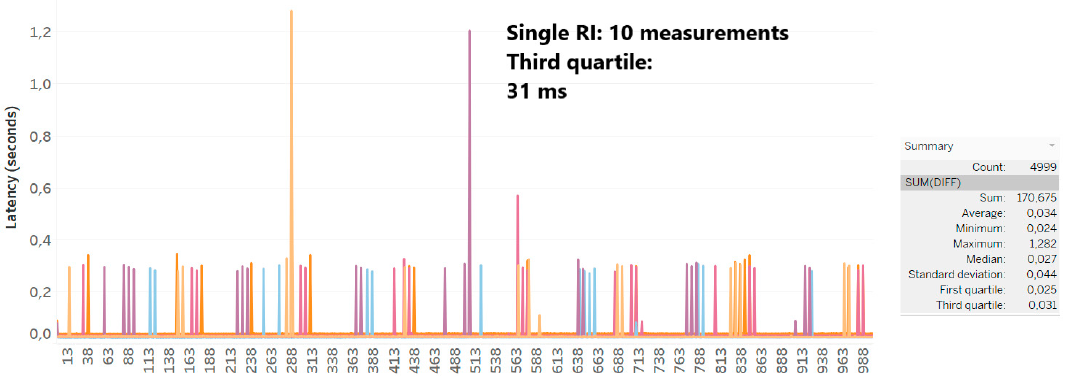
Figure 8. Single RI results for JaNDER Level 0 test: 10 measurements for every repetition.